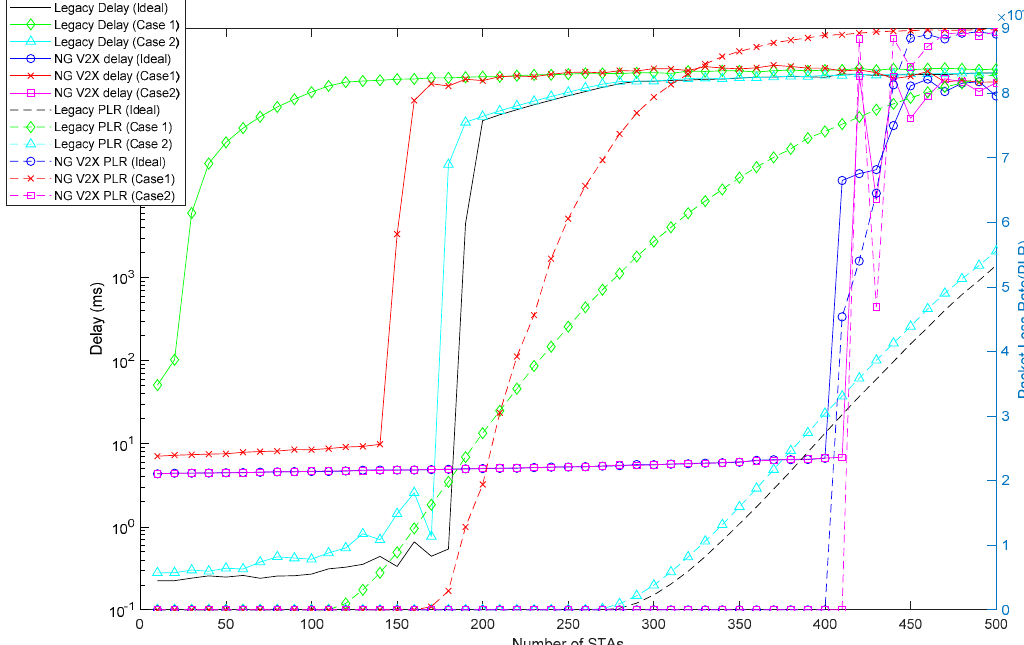
Figure 16. Average delay and PLR comparison between legacy and proposed NG-V2X for various channel cases (ideal channel case, case 1 and case 2).